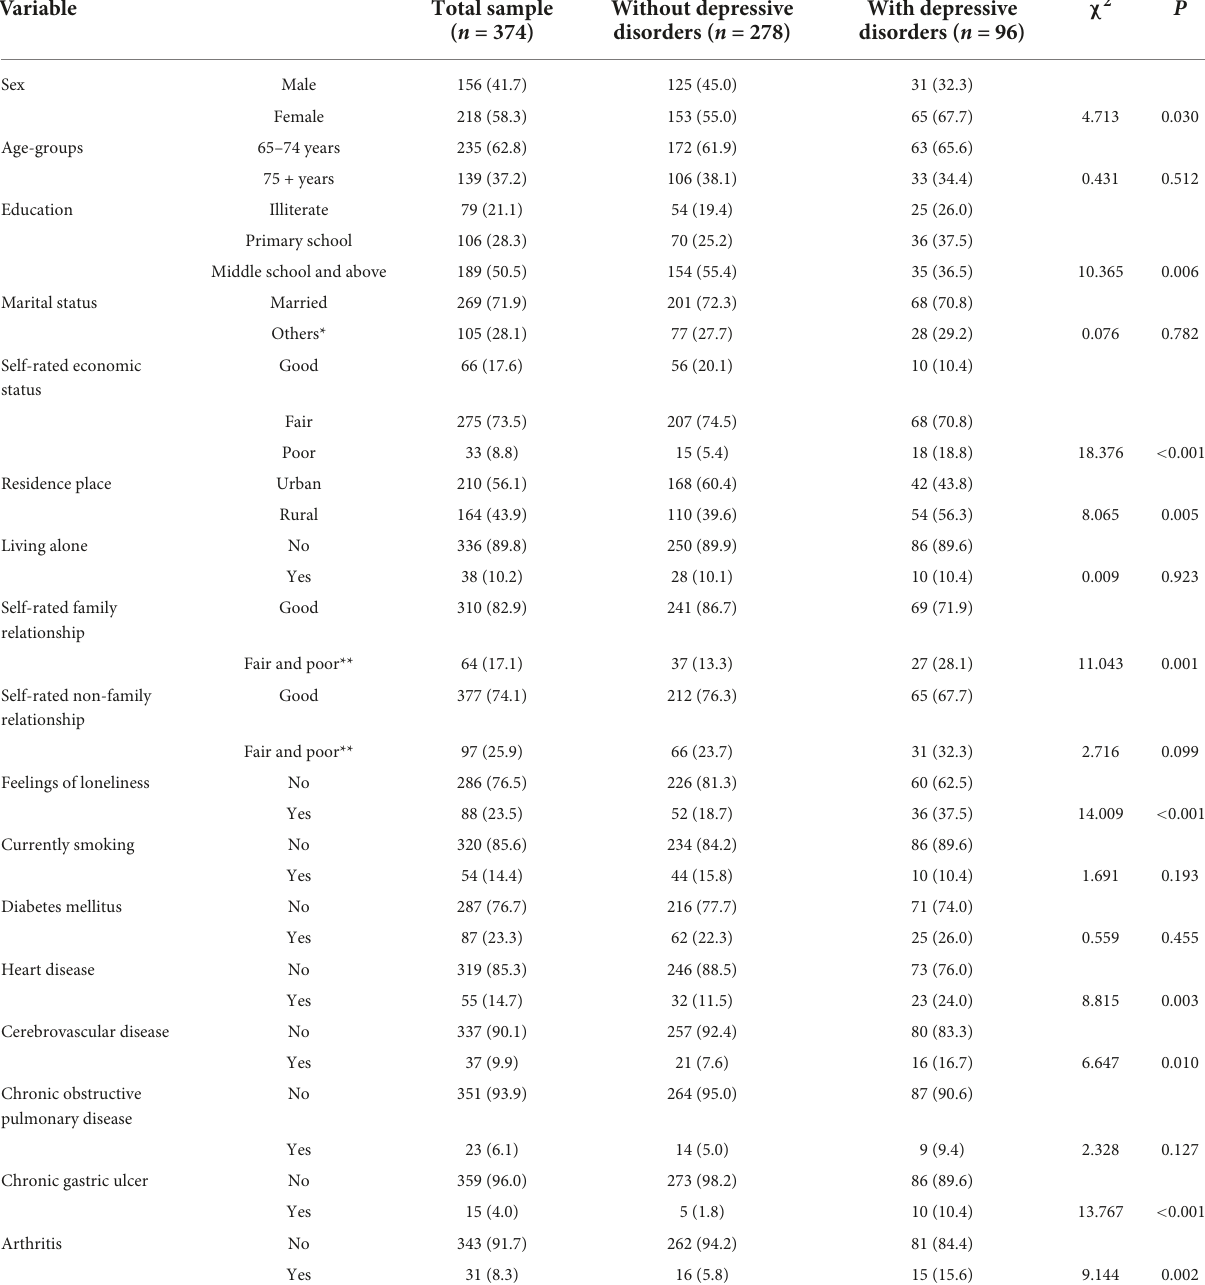
TABLE 1 Characteristics of hypertensive older Chinese adults, split by the presence and absence of depressive disorders, n (%). Variable Total sample